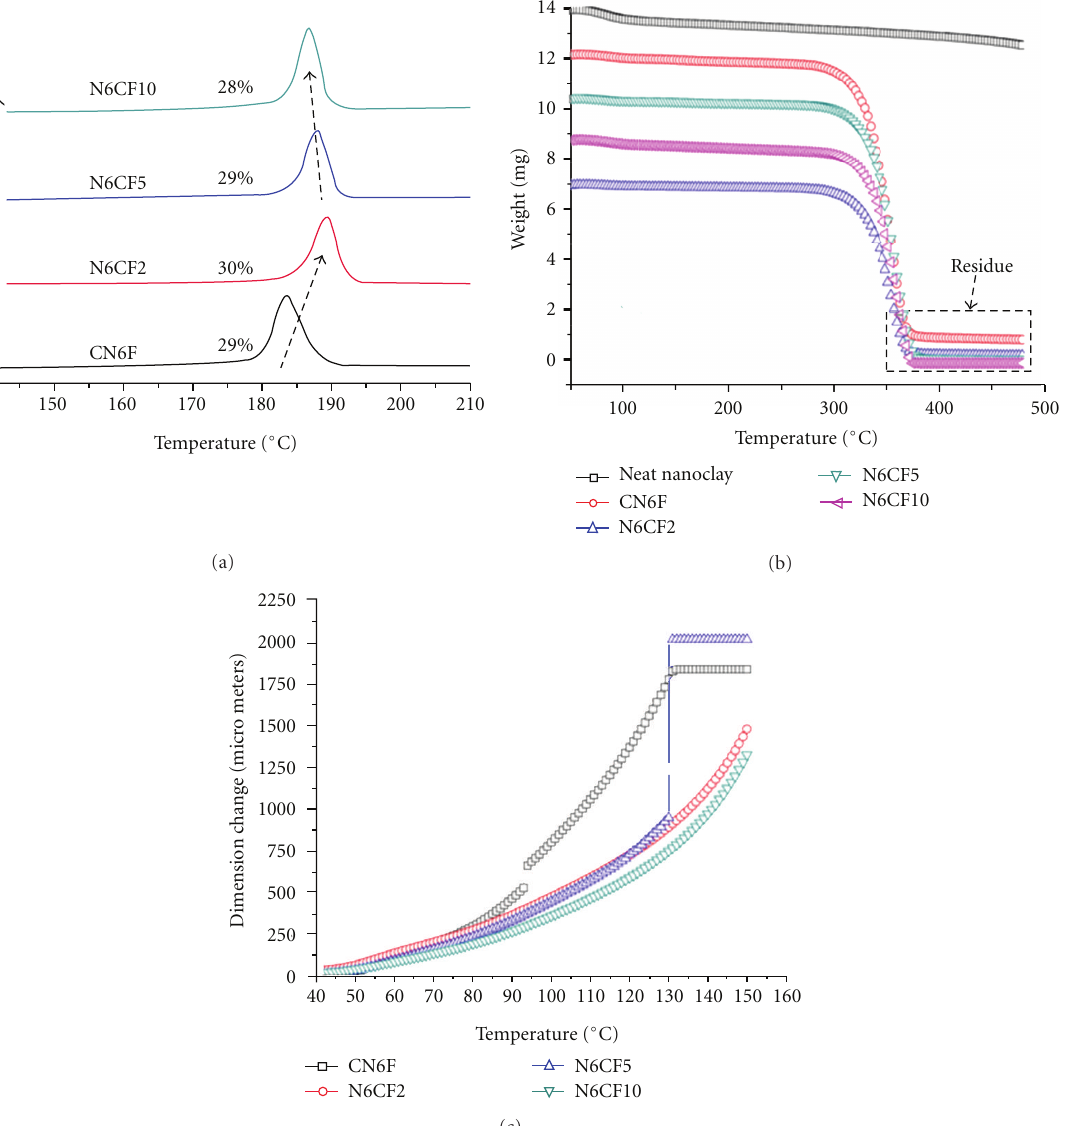
Figure 6: (a) DSC cooling segment scans of samples, (b) TGA scans of film samples, (c) TMA scans of samples. (Color figure can be viewed in the online